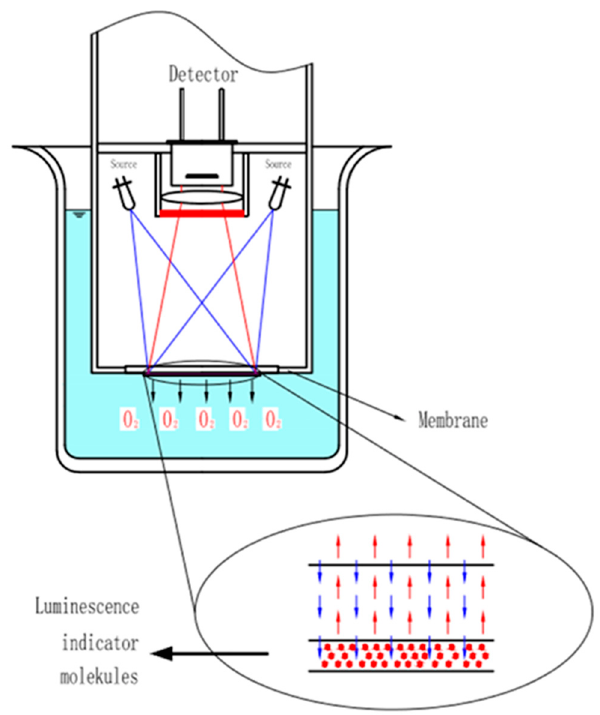
Figure 3. Fluorescence quenching of dissolved oxygen sensor probe.